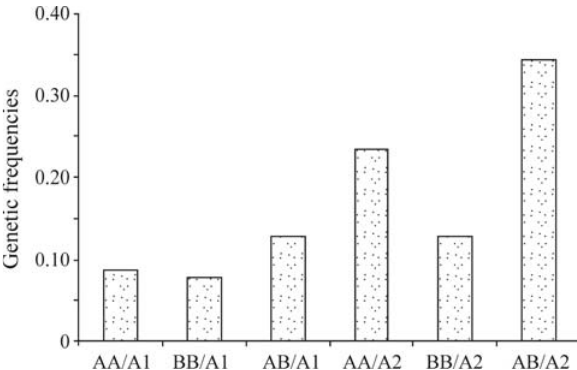
Figure 2 - Frequency of the association between estrogen receptor and retinol-binding protein 4 polymorphism genotypes in sows of a commer- cial population from Brazil.